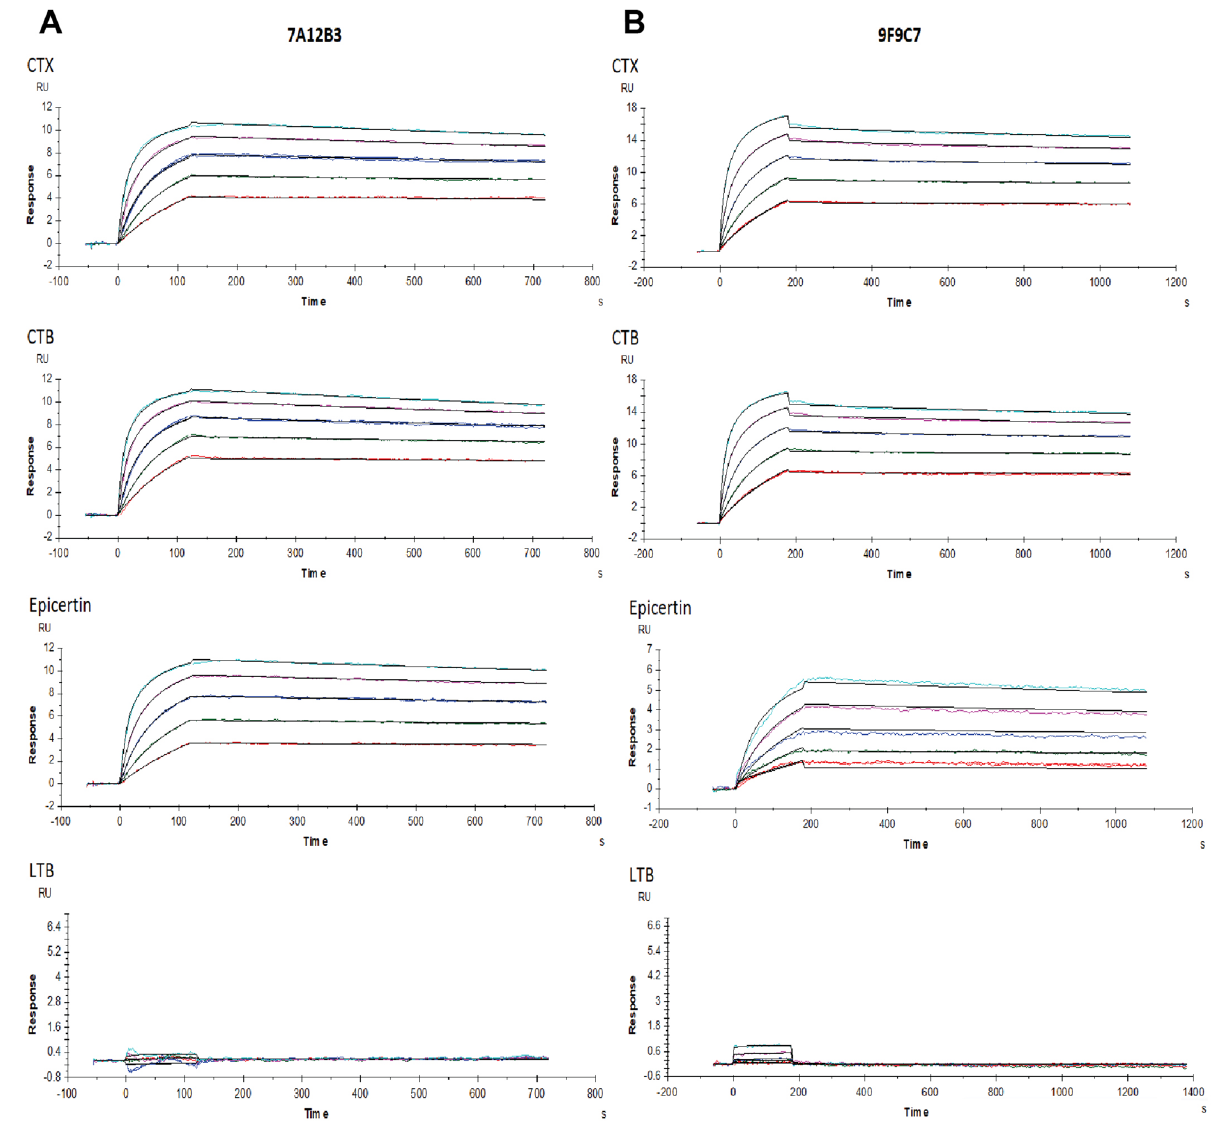
Figure 3. SPR analysis of 7A12B3 and 9F9C7 mAbs binding affinities to CTX, CTB, EPICERTIN and LTB. Each mAb was immobilized on a CM5 sensor chip. Each analyte (CTX, CTB, EPICERTIN, and LTB) was tested in a range of concentrations (0, 1.68, 3.37, 6.73, 13.47, 26.9375 nM) against immobilized 7A12B3 mAb or 9F9C7 mAb (0, 106.3, 212.5, 425, 850, 1670 nM). The collected kinetic data were blank subtracted, so the concentration at 0 nM is not shown. Representative sensorgrams for (A) 7A12B3 and (B) 9F9C7 are shown after Bivalent model fitting. Each experiment was conducted with at least three replicates.